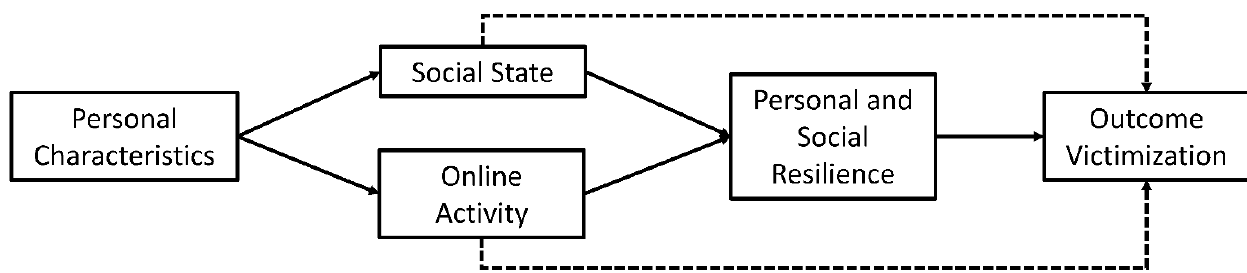
Figure 1. The theoretical structural model, direct and indirect effects. Note: Straight arrows for direct regression effects; dashed arrows for indirect regression effects.